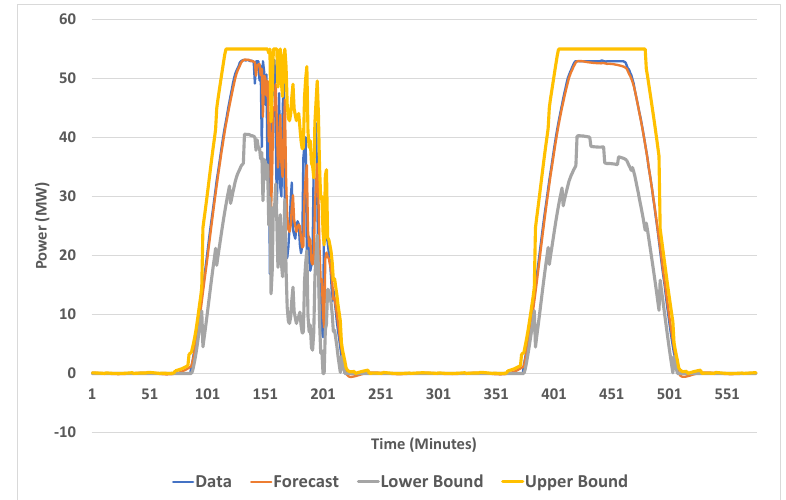
Figure 9. Probabilistic forecasting example for Broken Hill solar farm.